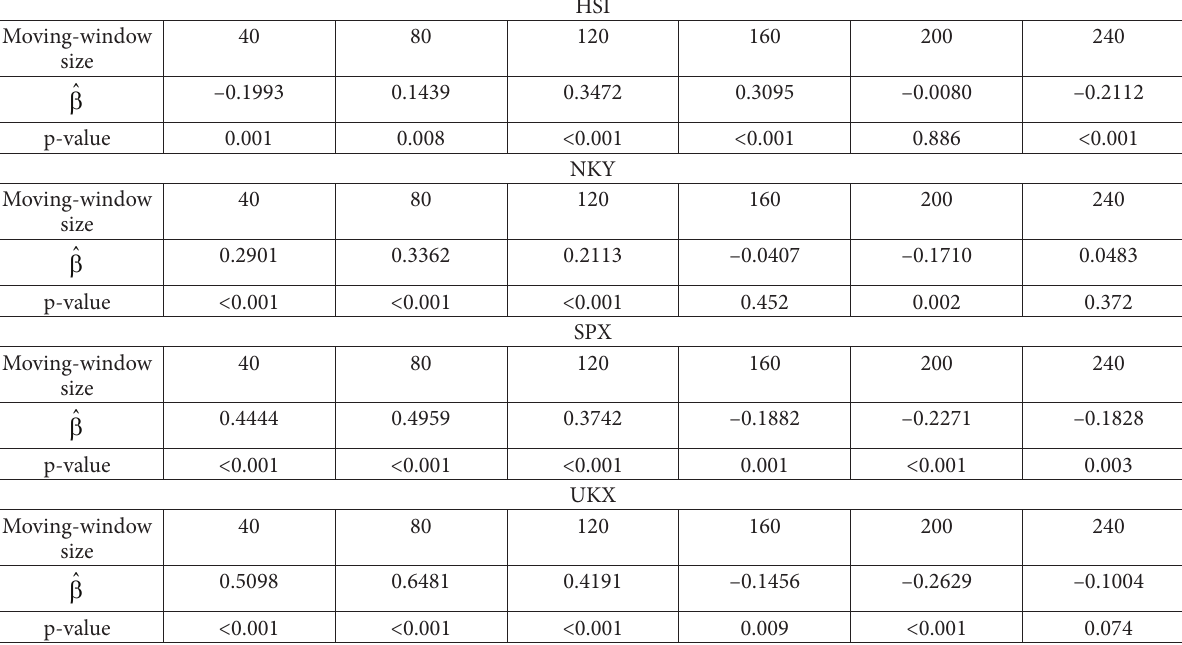
Table 12. The test results for the Halloween effect using Method